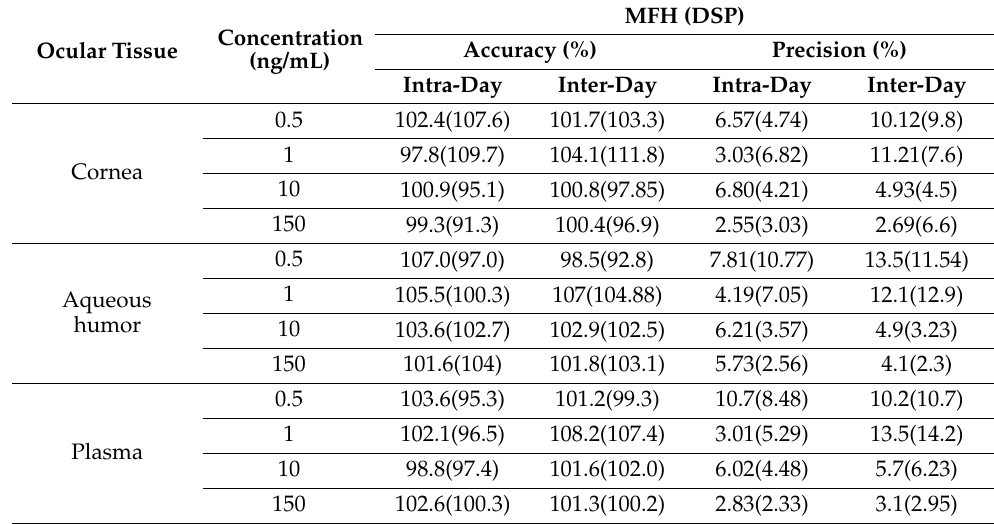
Table 2. Accuracy and precision data for MFH and DSP at the LLOQ, LQC, MQC, and HQC levels in ocular tissue (n = 6).